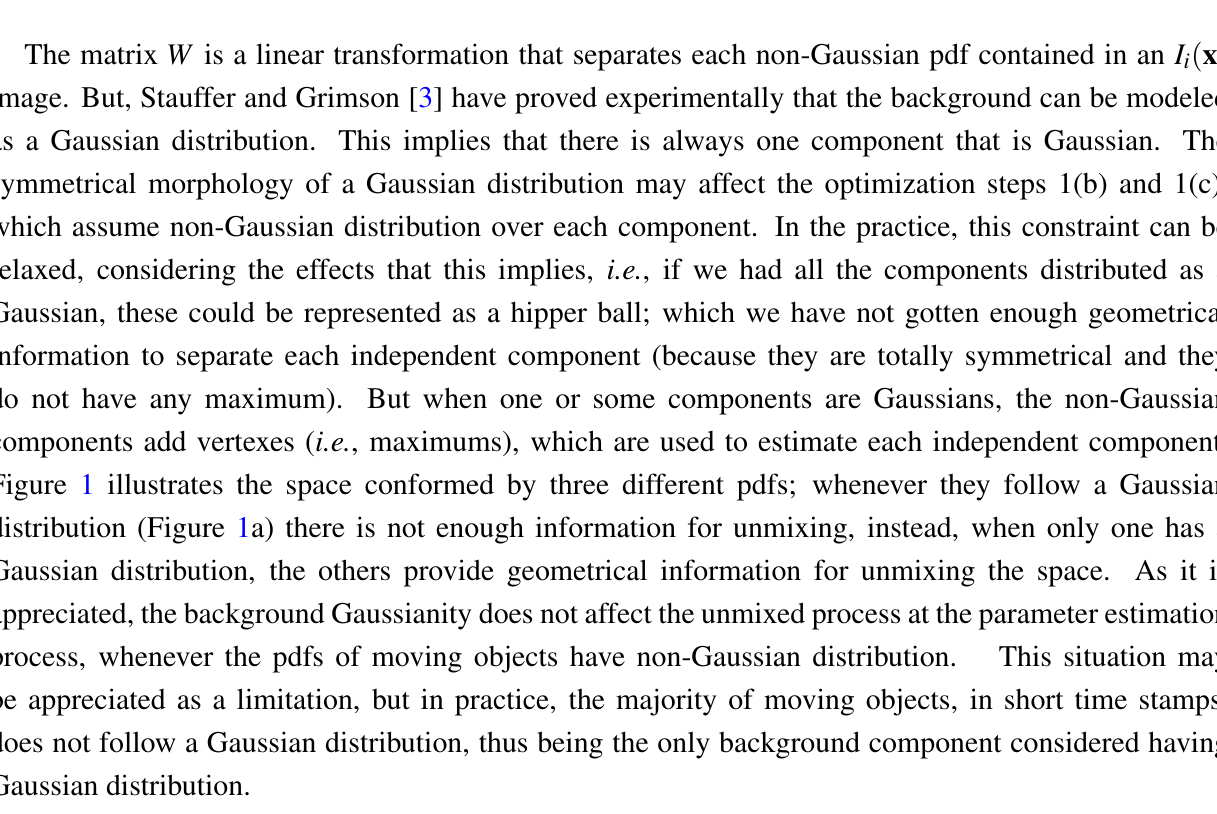
Figure 1. Data distribution for 3 variables (a) when data have a Gaussian Distribution there is not enough information to estimate each independent component (the